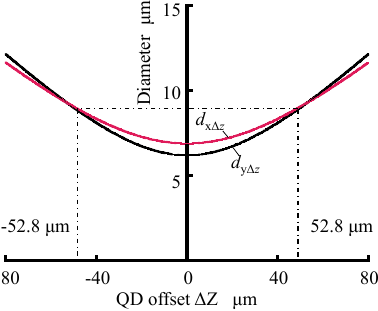
Figure 4. Relationship between the position offset and the laser beam diameter.